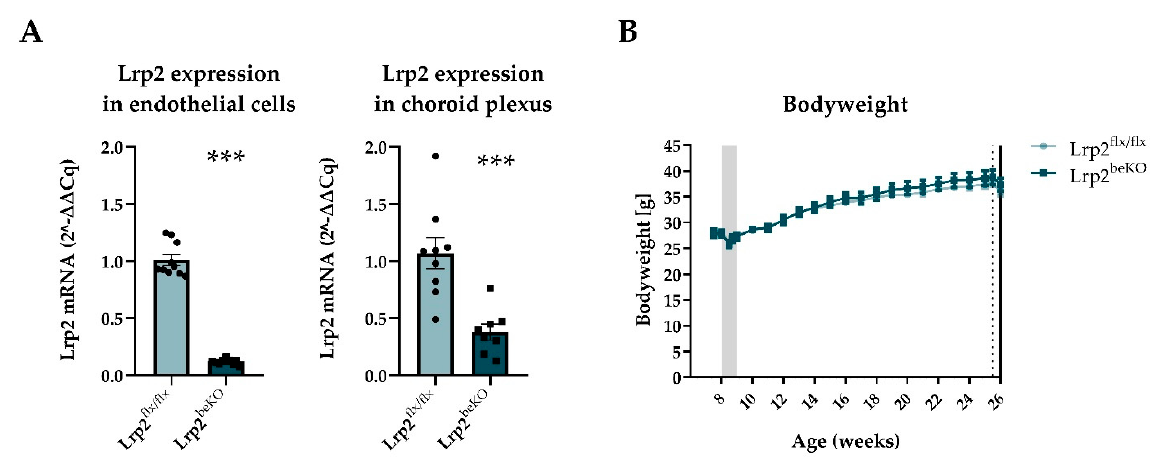
Figure 3. Endothelial cell and choroid plexus LRP2 reduction but no alteration of bodyweight in Lrp2 brain endothelial knockout mice (Lrp2 beKO ) compared to Lrp2 floxed littermates (Lrp2 flx/flx ). Lrp2 was successfully deleted in both brain endothelial cells and choroid plexus ( A ) n = 8–10. No change in body weight was observed between Lrp2 beKO mice and Lrp2 flx/flx mice over time. Shaded area indicates tamoxifen injection days, dotted line indicates body composition measurement, and whole line indicates start of calorimetry ( B ) n = 10. Results are presented as mean ± SEM *** p < 0.001.